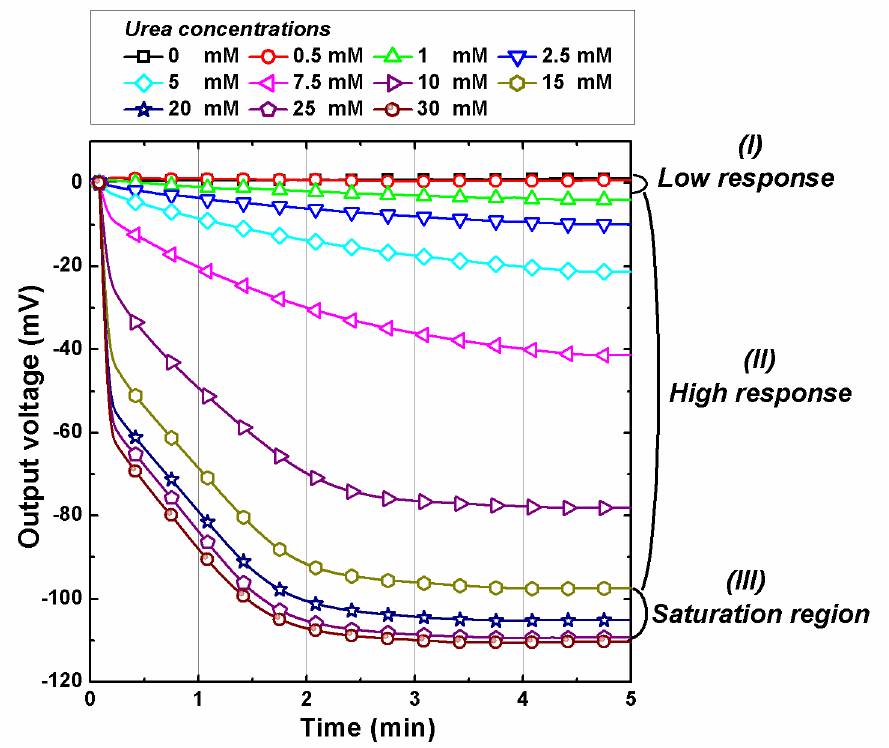
Figure 6. Time response to output voltage measured in 0–30 mM